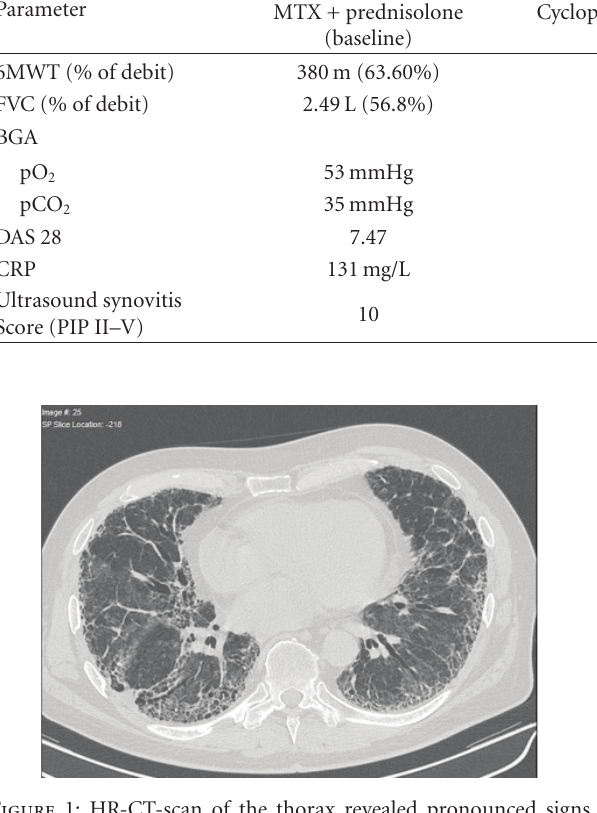
Figure 1: HR-CT-scan of the thorax revealed pronounced signs of pulmonary fibrosis including consolidations and honeycombing especially in basal